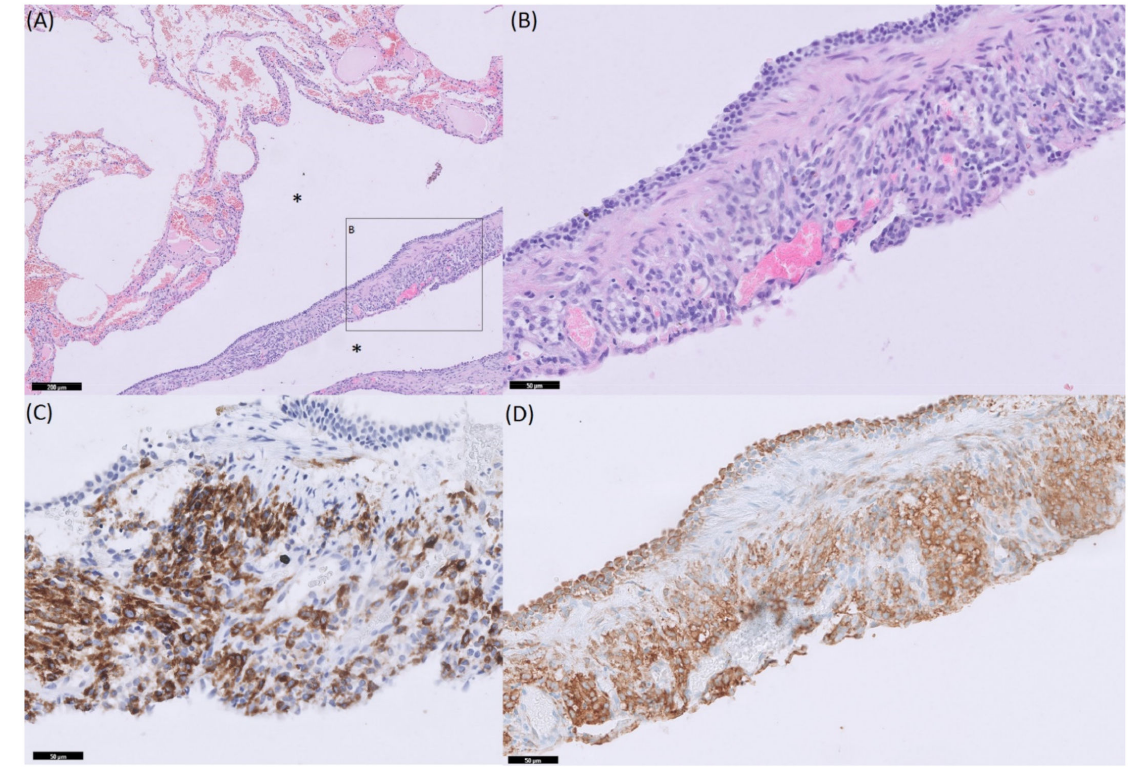
Figure 1. Example of Immunohistochemistry (IHC) staining in lung tissue of a patient with lymphangioleiomyomatosis (LAM): ( A ) Hematoxylin-eosin (HE) staining. Upper part of ( A ) represent normal lung parenchyma, lower part demonstrates affected tissue. Asterisks represent cystic space. ( B ) Higher magnification of area B from ( A ), ( C ) human melanoma black (HMB45) staining, and ( D ) p-S6 (S6K activity)